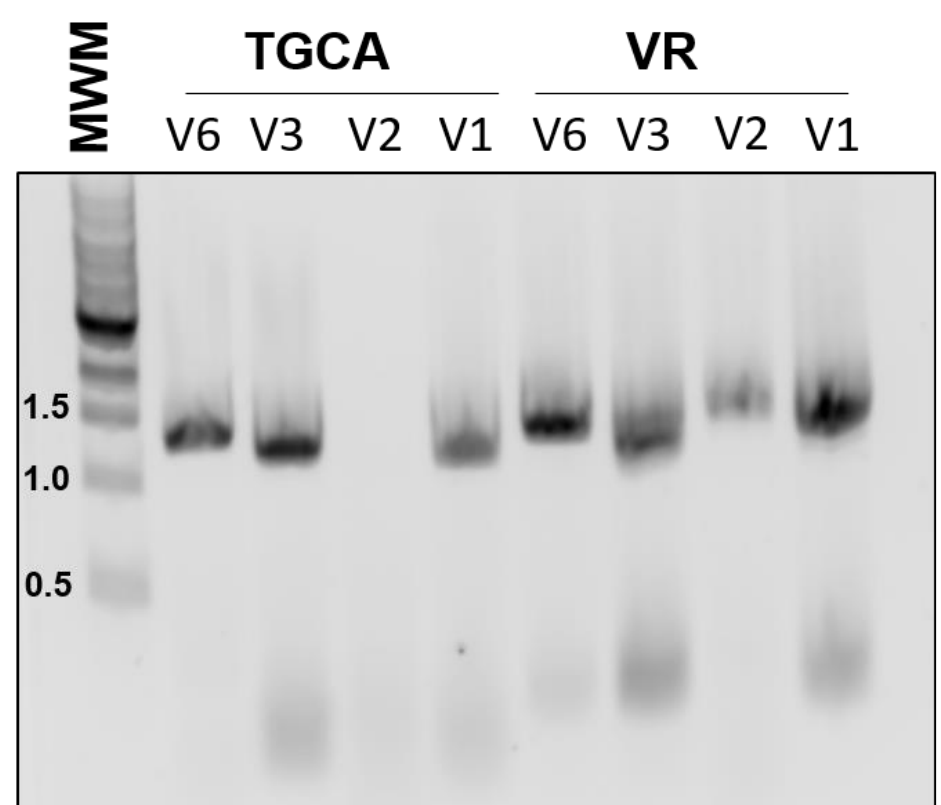
Figure 2. Amplification of a BioBrick with GEM-gate primers. BioBrick BBa_J04450 (0.5 ng), cloned with plasmid pSB1C3, was amplified using forward primers (versions 1 through 6) with an AATT overhang and either reverse TGCA version 6 or a control reverse primer (VR). A total of 34 cycles of amplification with 20 s at 57 °C and 60s at 72 °C were carried out and the resulting DNA was resolved on a 0.8% agarose gel. MWM is the 1 kbp+ ladder (New England Biolabs) with DNA sizes in kbp indicated. Results are representative of at least three independent experiments.